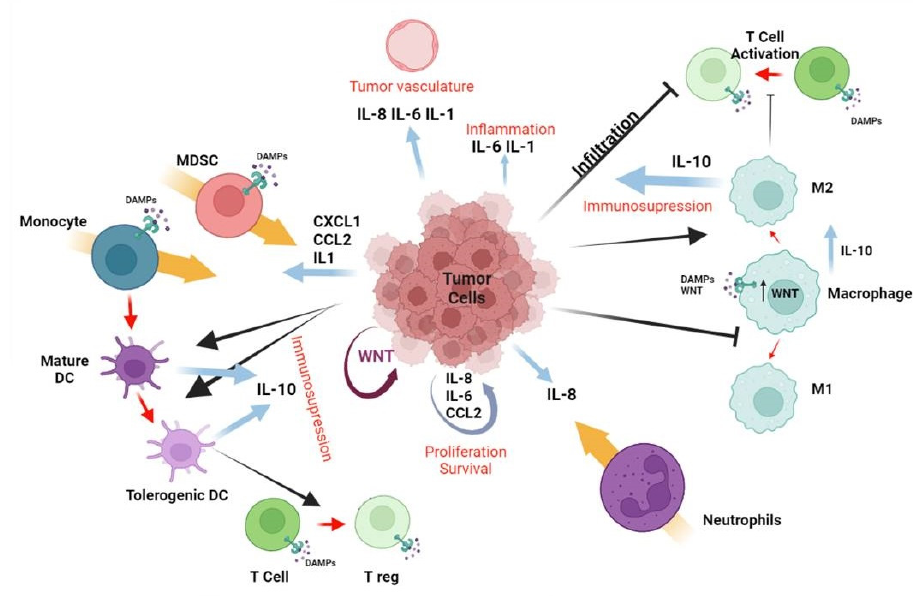
Figure 5. Immunomodulatory effects of WNT on the tumor microenvironment. The autocrine effect of WNT (garnet arrow) drives the secretion of various cytokines and chemokines by tumor cells (blue arrows), which in turn promote different processes (in red) and chemotaxis of various cell types (orange arrow). WNT also promotes IL-10 secretion by dendritic cells (DC) and macrophages. WNT released by tumor cells promotes (black lines with arrowheads) or inhibits (black lines) maturation and/or differentiation (red arrows) of immune cells. The effects associated with WNT are angiogenesis, inflammation, and immunosuppression, as well as proliferation and survival of tumor cells. Created with BioRender.com (accessed on 21 March 2022).